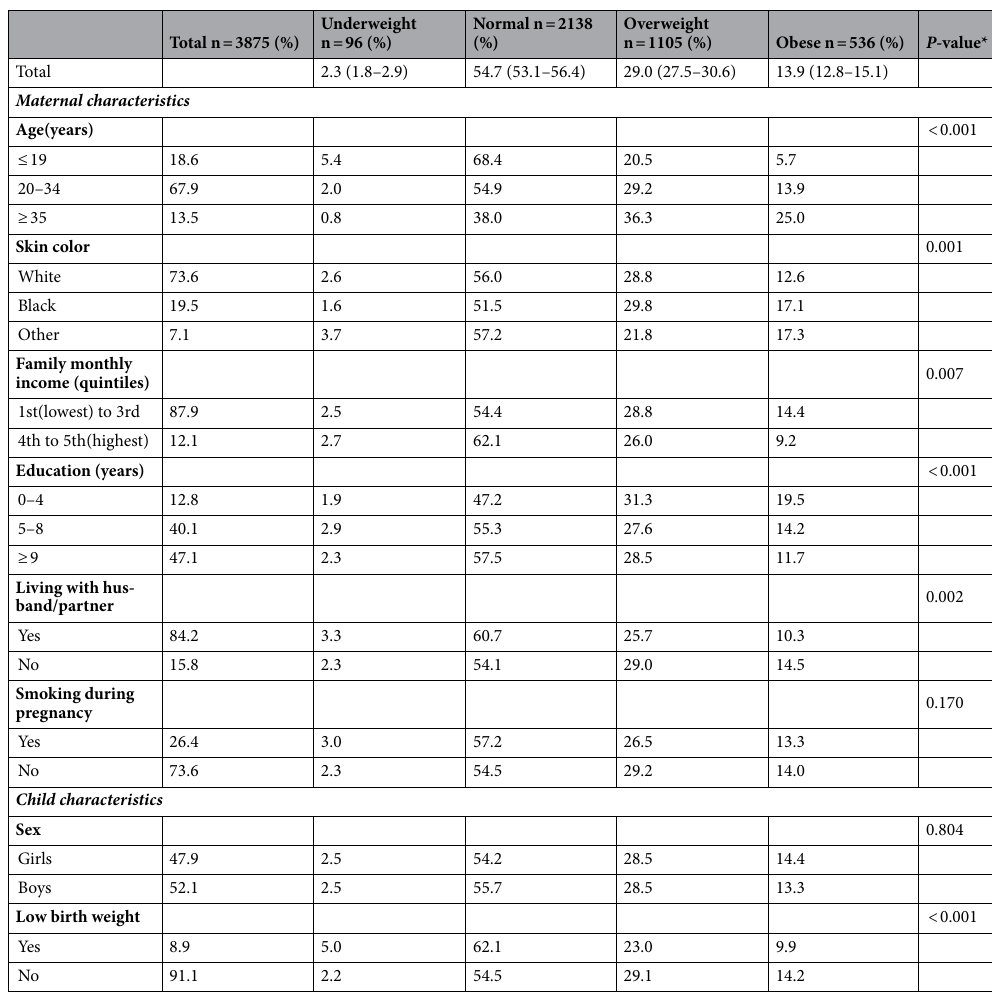
Table 1. Maternal pre-pregnancy body mass index (BMI), according to maternal and child characteristics. * X 2